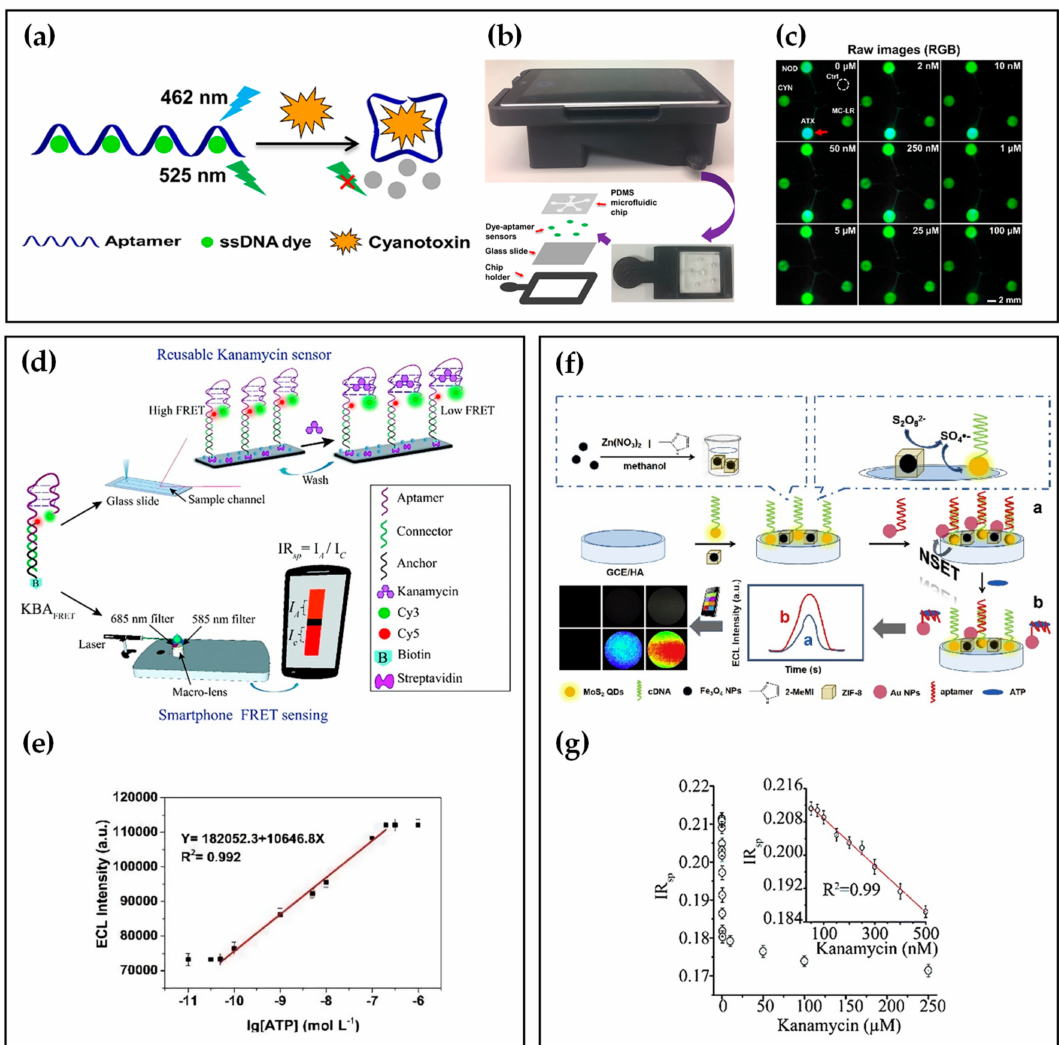
Figure 2. ( a ) Detection theory of the fluorescent aptasensor. Reprinted with permission from Ref. [59], copyright 2019, American Chemical Society. ( b ) Schematic illustration of the smartphone − based fluorescent aptasensor. Reprinted with permission from Ref. [59], copyright 2019, American Chemical Society. ( c ) Raw fluorescence images in response to different concentrations of ATX. Reprinted with permission from Ref. [59], copyright 2019, American Chemical Society. ( d ) Schematic of FRET-based kanamycin aptasensor. Reprinted with permission from Ref. [60], copyright 2019, Royal Society of Chemistry. ( e ) Calibration curve for Kanamycin detection. Reprinted with permission from Ref. [60], copyright 2019, Royal Society of Chemistry. ( f ) Schematic of the ECL biosensor. Reprinted with permission from Ref. [63], copyright 2020, Elsevier. ( g ) Correlation between the ATP concentration and ECL intensity. Reprinted with permission from Ref. [63], copyright 2020,